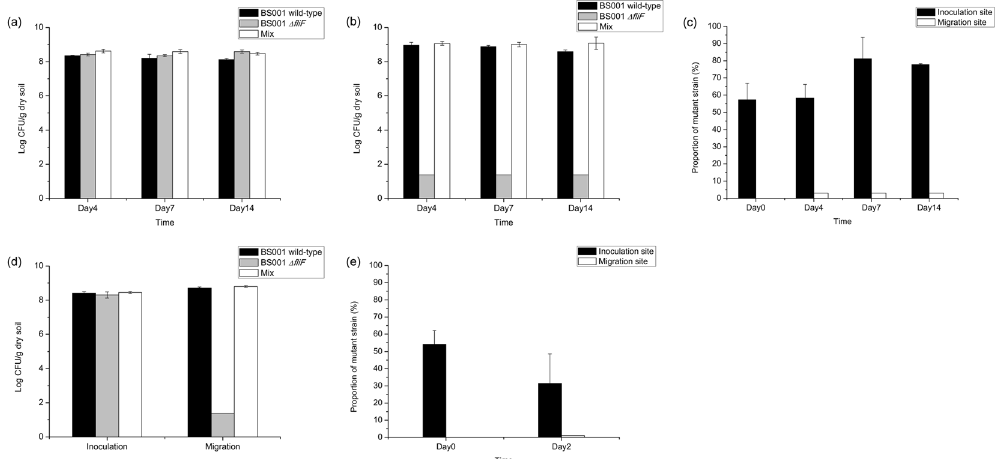
Figure 4. Population dynamics of wild-type and Δ fliF mutant strains in soil microcosms over time. ( a ) Cell density at the inoculation site, at Lyophyllum sp. strain Karsten. ( b ) Cell density at the migration site of Lyophyllum sp. strain Karsten. ( c ) Proportion of B. terrae BS001 Δ fliF mutant strain in the total BS001 population in the mycosphere of Lyophyllum sp. strain Karsten. ( d ) Cell density at day 2 in the microcosm of T. asperellum 302. ( e ) Proportion of B. terrae BS001 Δ fliF mutant strain in the total BS001 population in the mycosphere of T. asperellum